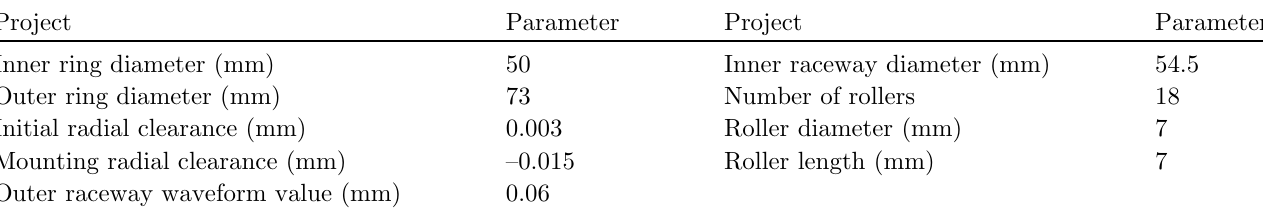
Table 1. Bearing